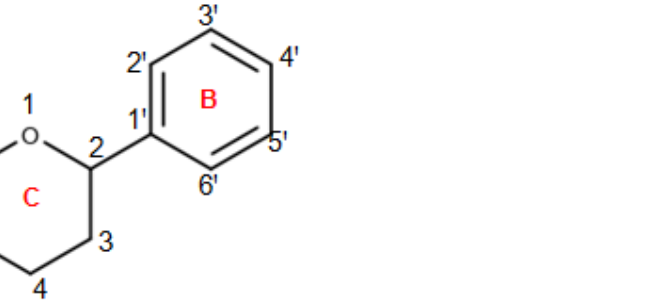
Figure 3. Representation of the chemical structure of 2-Phenylchroman, shows the basicnucleus of flavonoids, indicating the chroman ( A , C ) and the aromatic ring in position 2 ( B